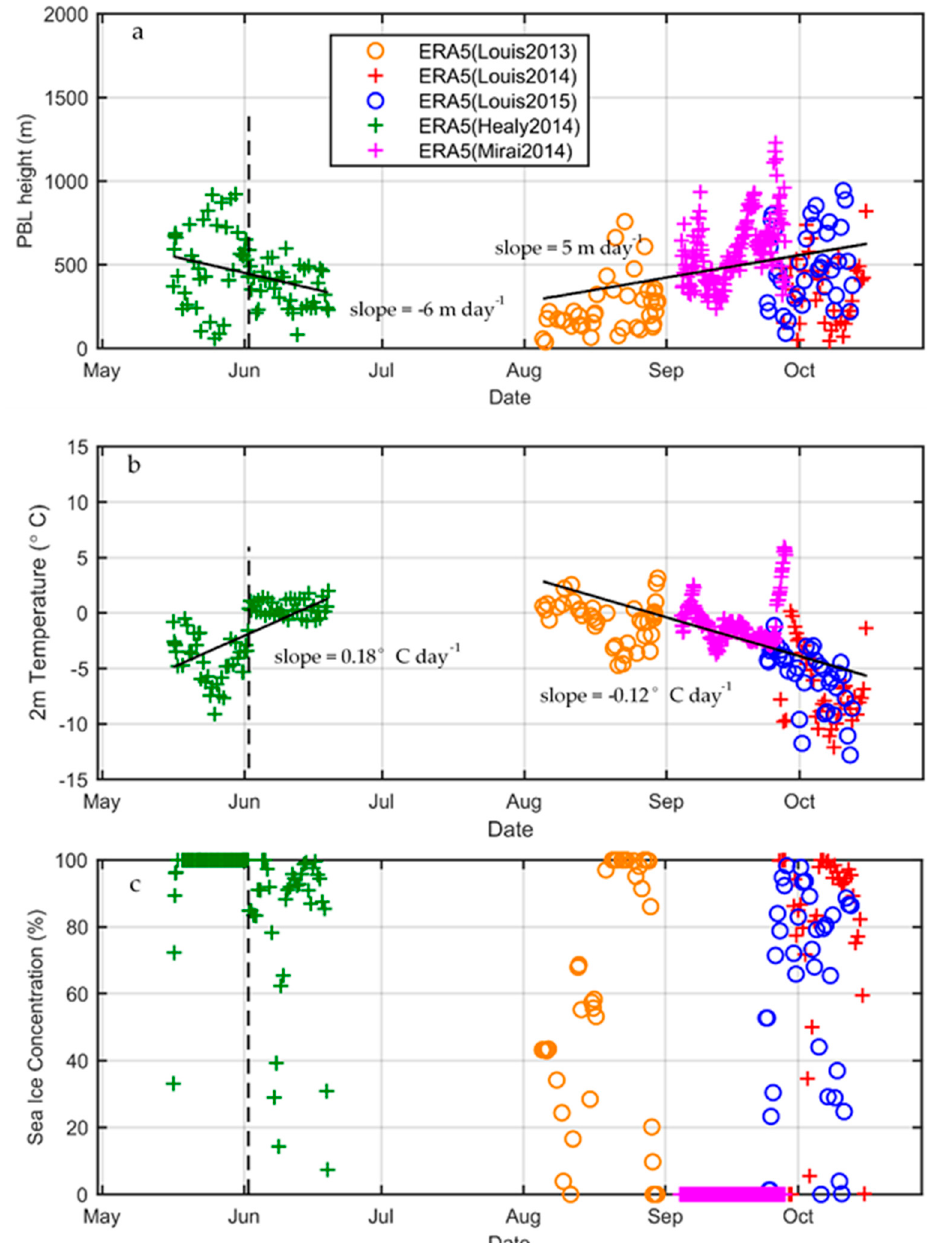
Figure 3. Same as Figure 2, but for ERA5 planetary boundary layer heights ( a ), 2-meter temperature ( b ), and sea ice concentration ( c ).